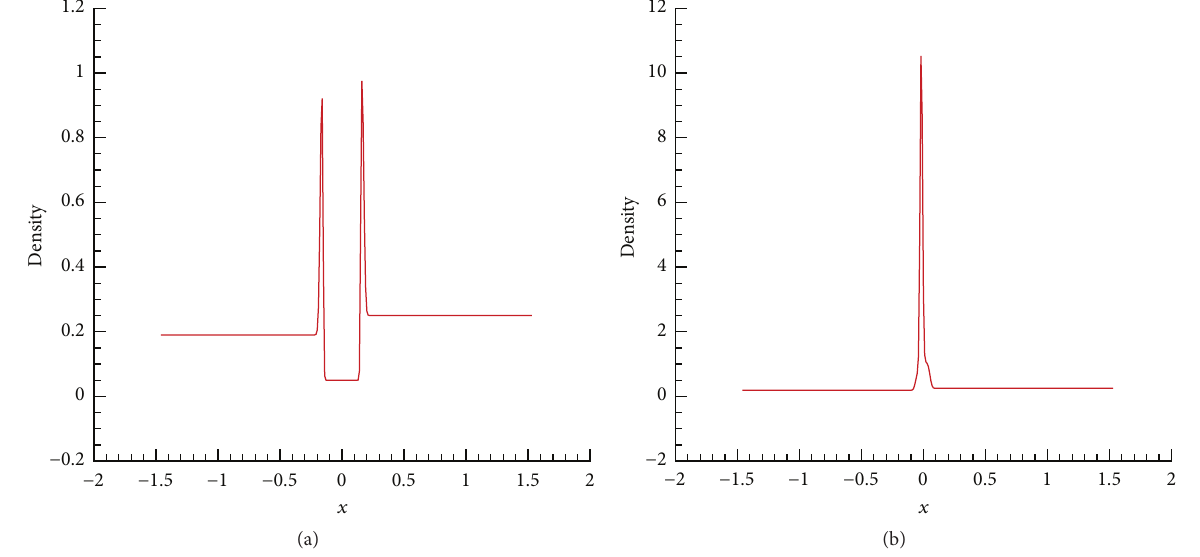
Figure 6: Numerical results of 𝜌 at 𝑡 = 1 (a) and 𝑡 = 6.5 (b) for Data